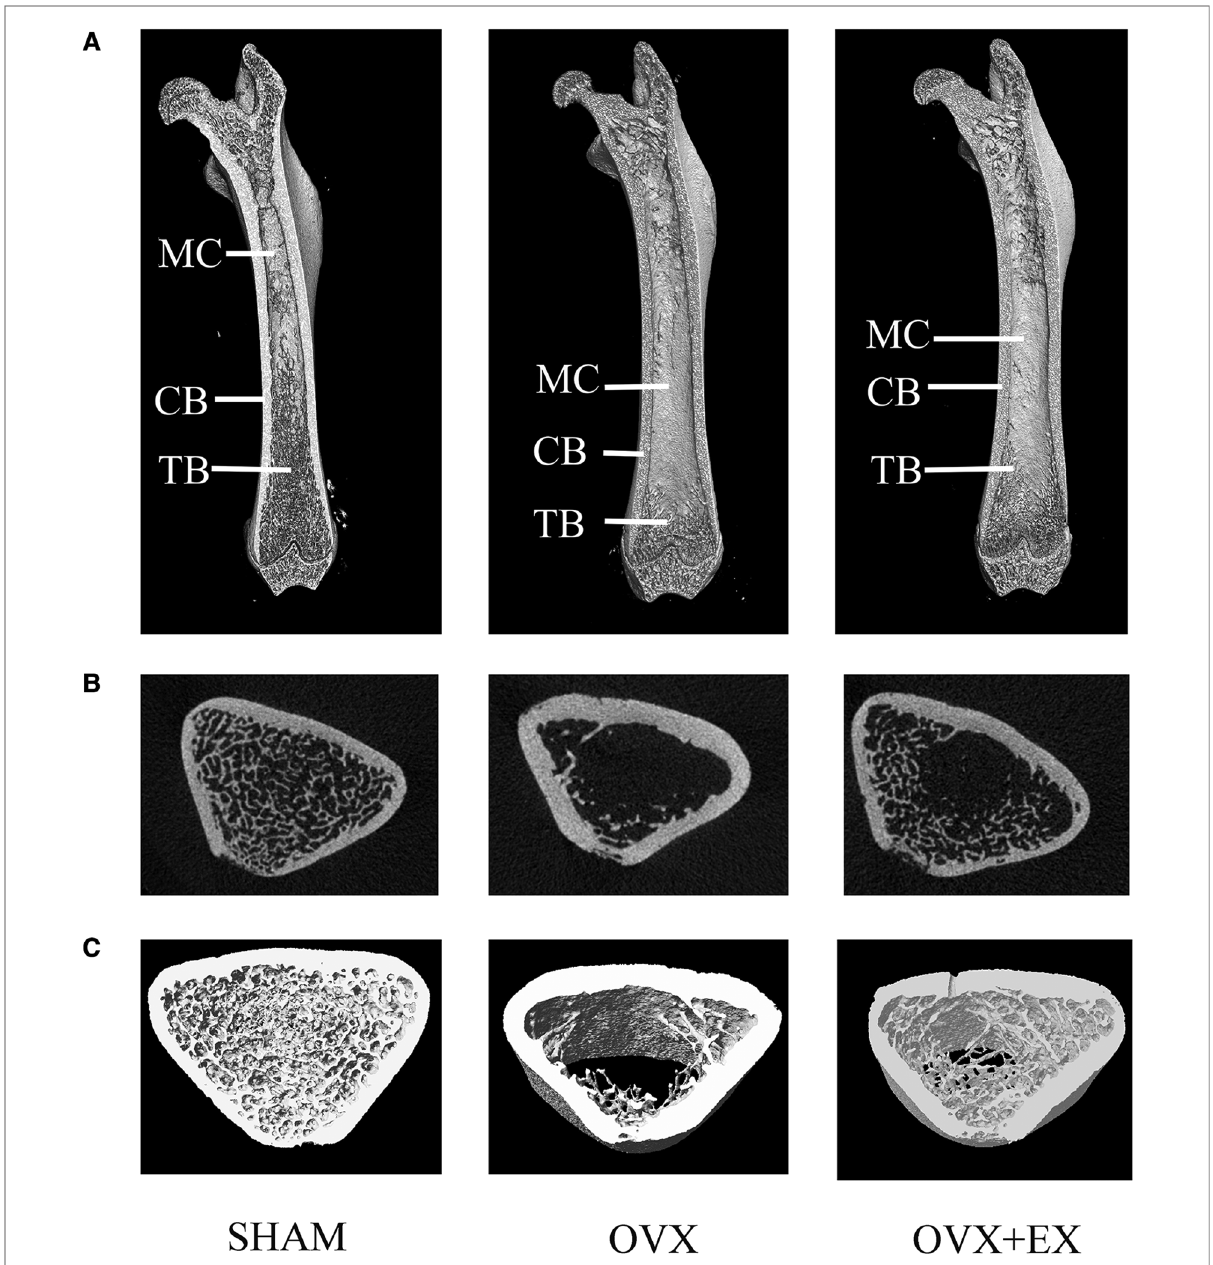
FIGURE 2 Two-dimensional structure of the longitudinal and transverse sections of the femur and the three-dimensional (3D) reconstruction of cancellous bone of the distal femur in the region of interest: ( A ) the longitudinal section of the femur; ( B ) the transverse section of the distal femur; and ( C ) 3D reconstruction of bone. (Representative micro-computed tomography pictures are shown here). MC, Marrow Cavity; CB, cortical bone; TB, trabecular